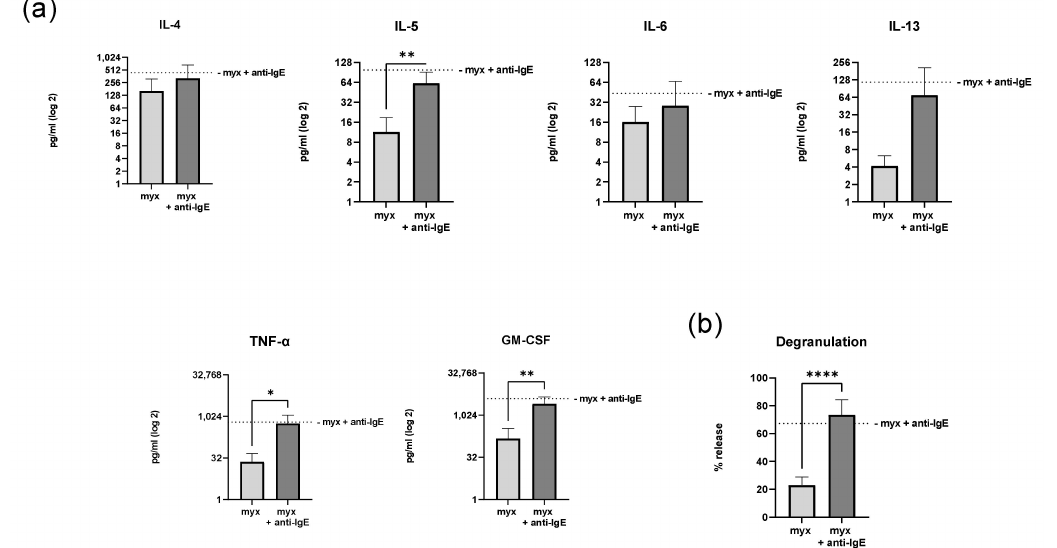
Figure 4. The inhibition of complex III of the respiratory chain does not affect anti-IgE-mediated cytokine and growth factor secretion and degranulation of human skin MCs. After inhibition of complex III using myxothiazol and IgE-mediated stimulation (anti-IgE), the human skin MCs’ cytokine and growth factor secretion ( n = 8; ( a )) and degranulation ( n = 7; ( b )) were analyzed under glucose-free conditions ( a , b : mean ± SEM, paired Student’s t -test: * p < 0.05, ** p < 0.01, **** p < 0.0001; one sample t -test of myx and anti-IgE-treated human skin MCs compared to the mean value of the anti-IgE-treated control cells without myx as indicated by the dotted line). anti-IgE = IgE-preloaded cells cross-linked with